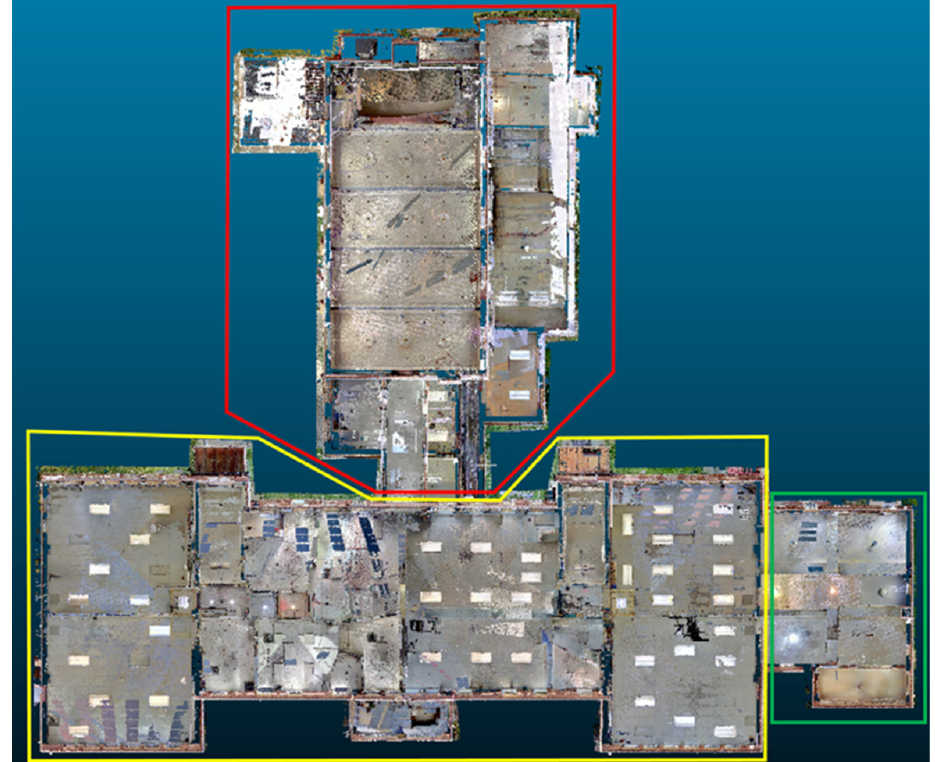
Figure 11. Old Sun sections: main building outlined in yellow, rear building in red, annex in green.